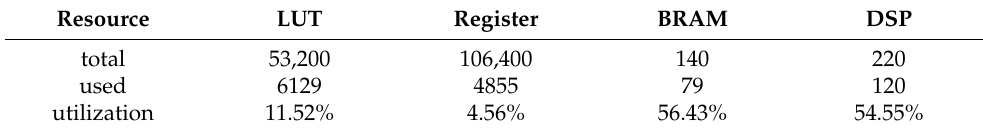
Table 3. Resource utilization of LeNet-5.